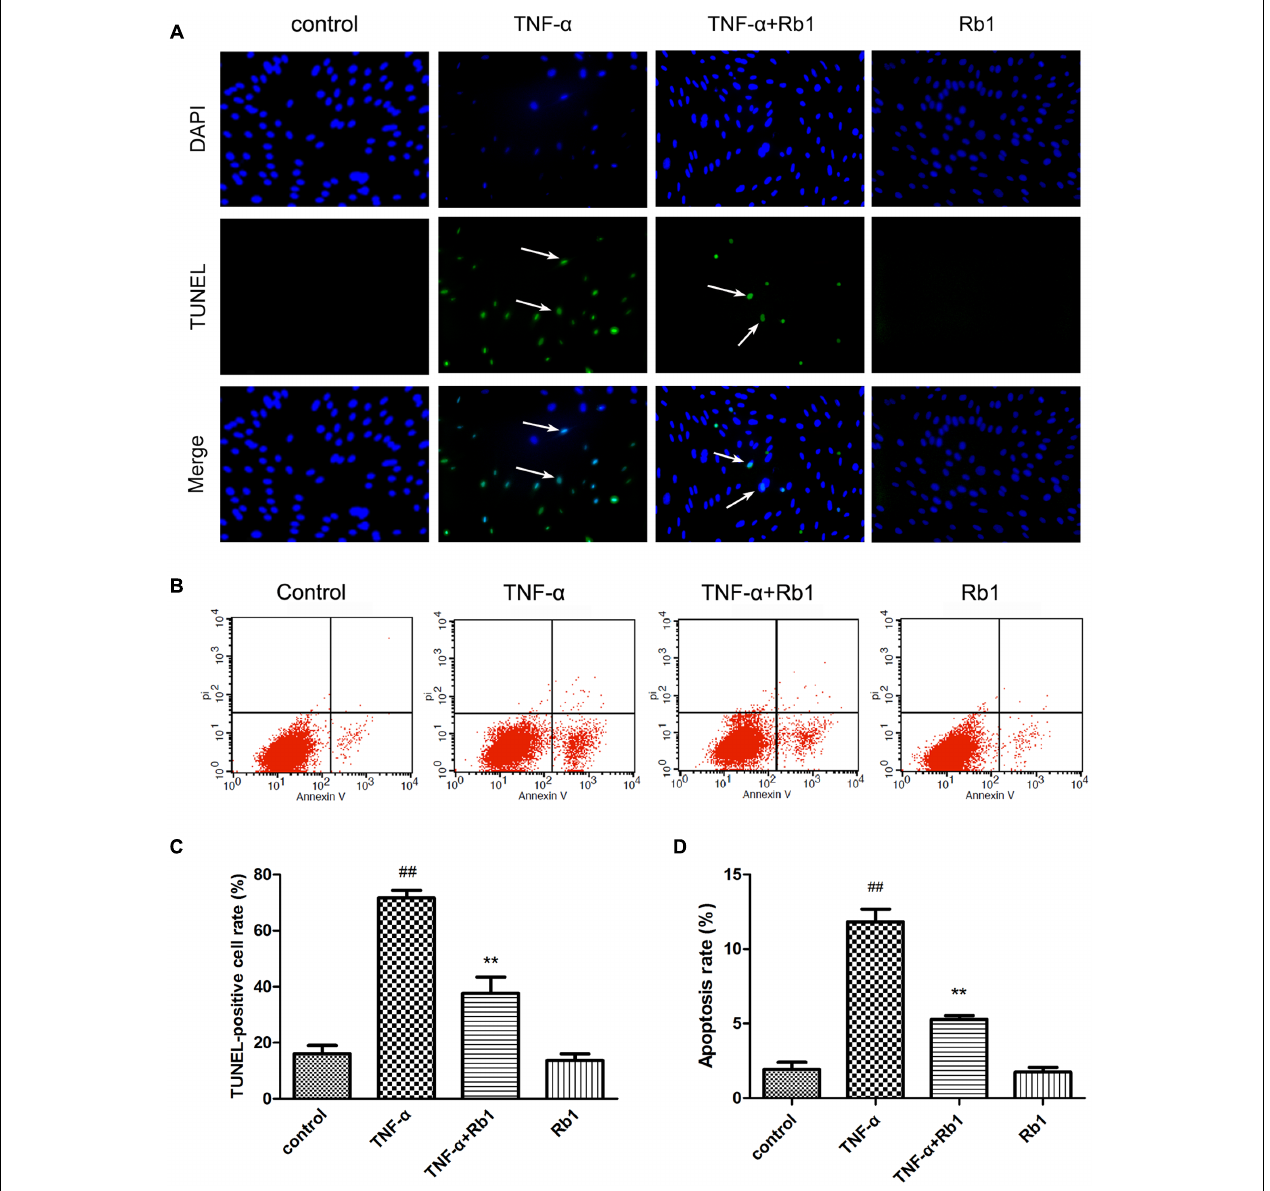
FIGURE 3 | Ginsenoside Rb1 could inhibit TNF- α -induced apoptosis. HUVECs were subjected to TNF- α for 24 h after being pretreated with Rb1 (20 µ g/mL) for 8 h. (A,B) Apoptosis of HUVECs was assessed by TUNEL staining and Annexin V/PI staining. (C) Quantitative analysis of TUNEL-positive cell rate. (D) Quantitative analysis of apoptosis rate. Data were expressed as the mean ± SD of three independent experiments. ## P < 0.01 vs. control group; ∗ P < 0.05, ∗∗ P < 0.01 vs. TNF- α treatment group.